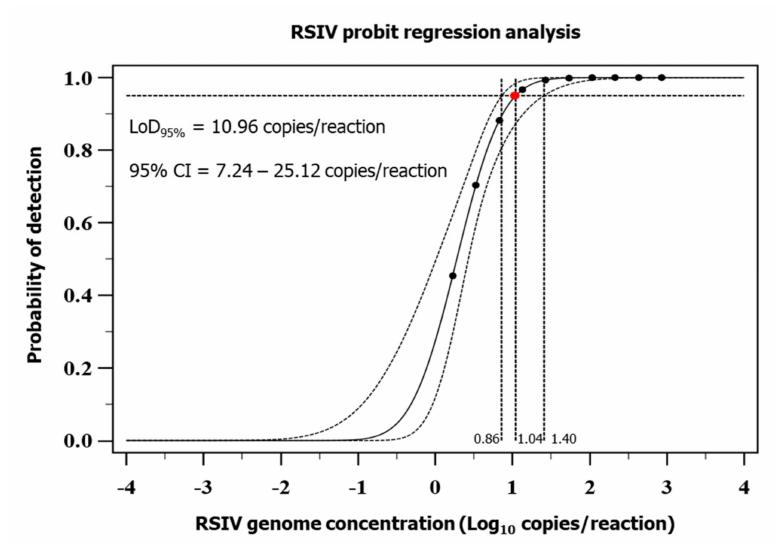
Figure 2. Analytical limit of detection (LoD 95% ) of the TaqMan-based real-time PCR assay. The plasmid DNA (pDNA) containing the Megalocytivirus major capsid protein ( MCP ) gene was serially diluted (from 860 to 1.68 copies/reaction) and tested. The probability of detection of each concentra- tion of the pDNA was calculated using 24 independent experiments and the LoD 95% was determined by probit regression analysis.